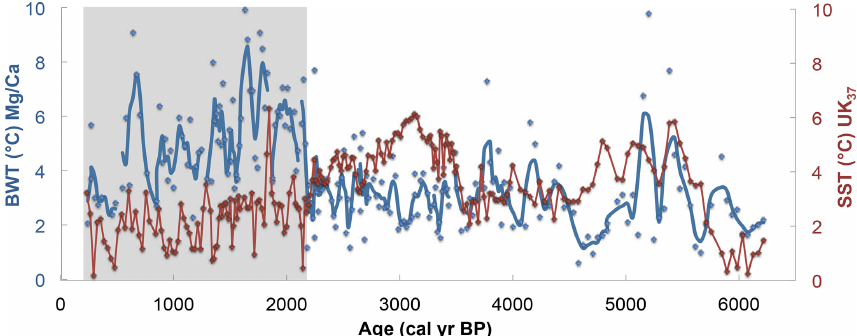
index and Mg / Ca ratios of 37